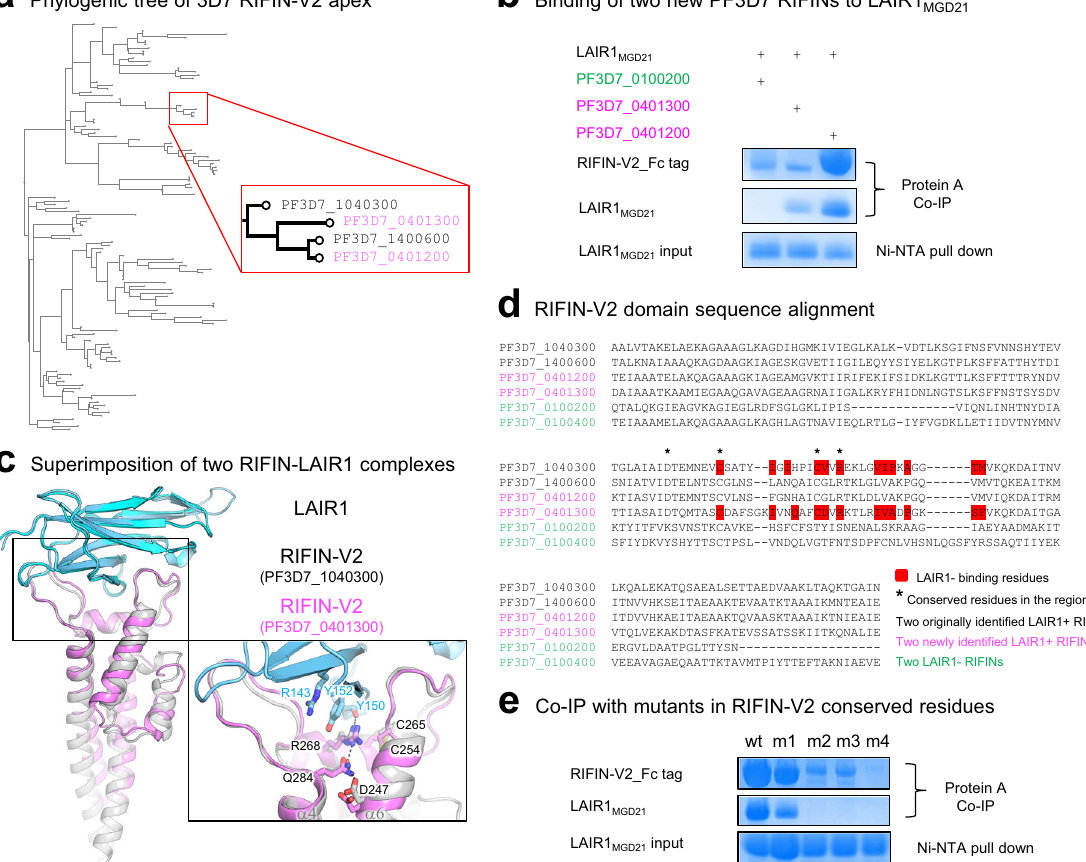
Fig. 3 LAIR1 targets a conserved interface within a subset of RIFIN family members. a Phylogenic analysis of plasmodium strain 3D7 RIFIN-v2 apex identi fi ed two additional RIFINs in the same branch as known LAIR1-binding RIFINs. b Co-IP assay con fi rmed the MGD21.LAIR1-binding by the two new RIFINs. The SDS-PAGE runs were repeated at least twice. c Superimposition of two RIFIN-LAIR1 complex structures. d Sequence comparison of MGD21- positive (cyan and magenta) and MGD21-negative (green) RIFINs V2 region, with LAIR1-binding region highlighted in red and conserved residues near the binding region marked with asterisks (*). e Co-IP with Alanine mutants in RIFIN-V2 four conserved residues. wt: wildtype PF3D7_1040300, m1: D247A, m2: C254A, m3: C265A, m4: R268A. The SDS-PAGE runs were repeated at least